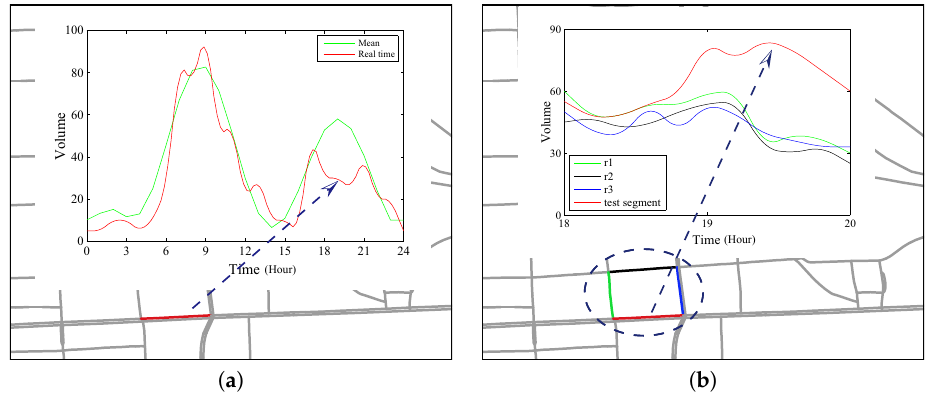
Figure 3. Two types of road anomalies. ( a ) Self-Evolving Anomaly; ( b ) Context-Evolving Anomaly.